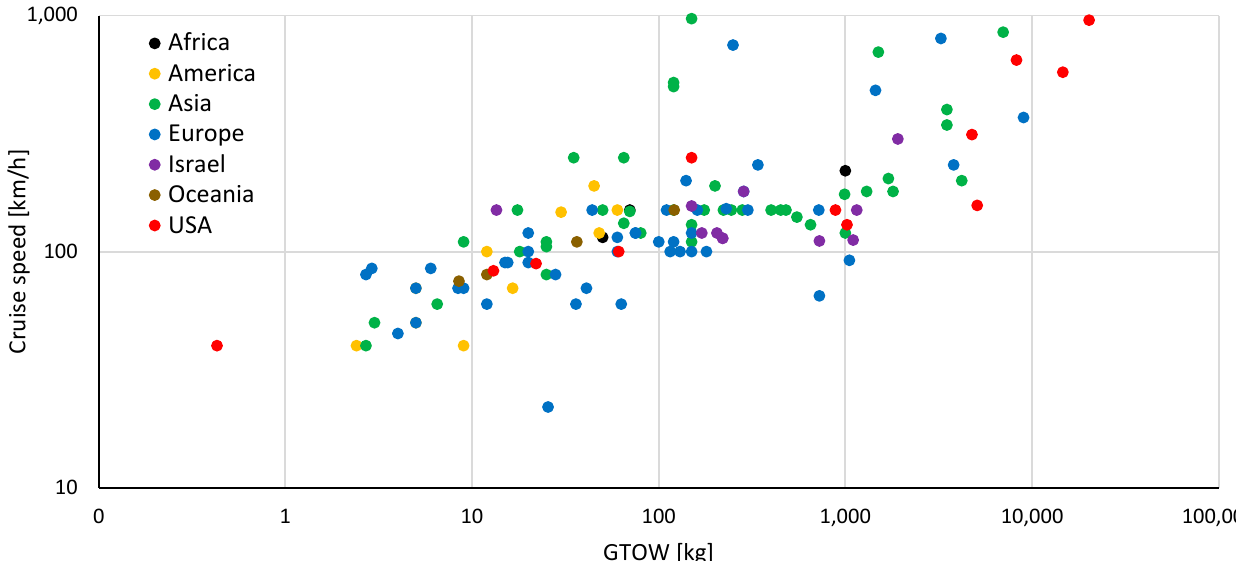
Figure 22. Cruise speed as a function of GTOW with respect to region of origin.